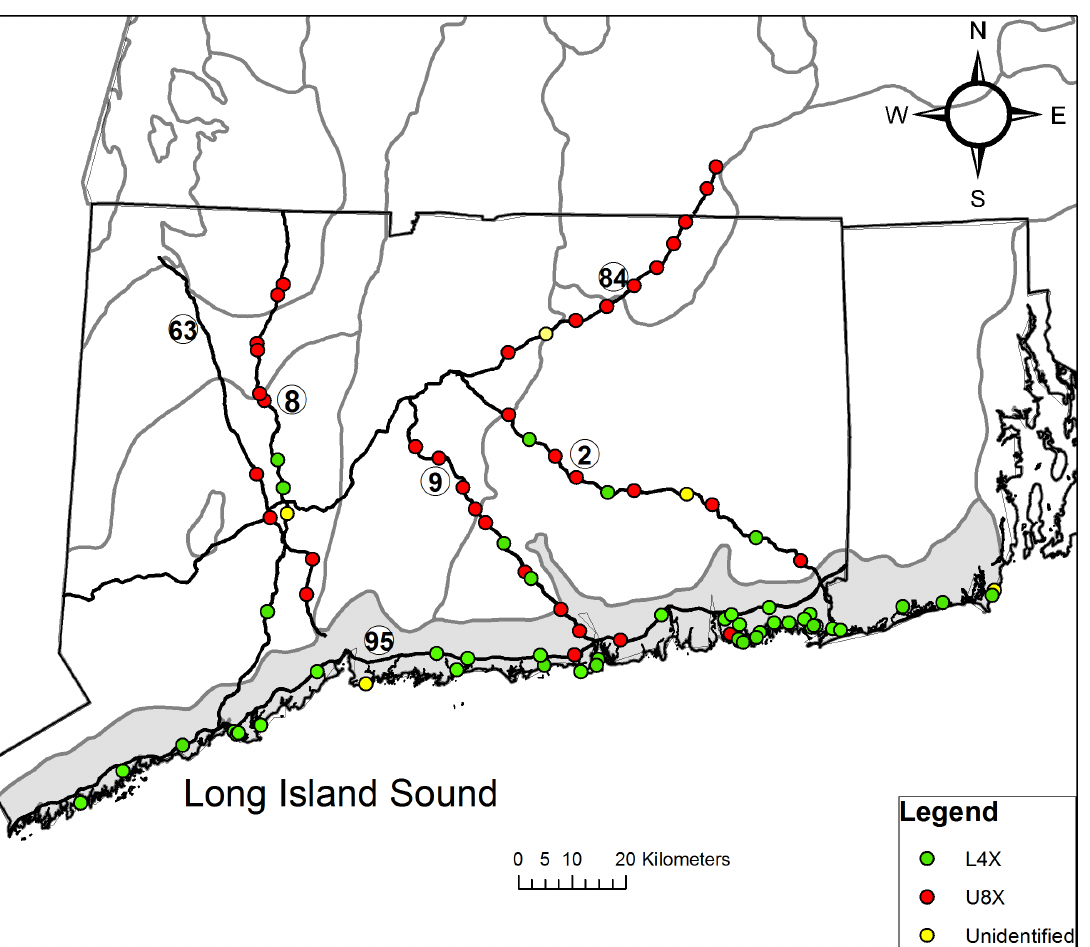
Fig 7. Map of study site showing distribution of switchgrass genotypes. Black lines represent borders of Connecticut and Rhode Island and six roads identified as Routes 63, 8, 9, 95, 84, and 2. Grey lines represent the borders of Level IV sub-ecoregions. The shaded area represents sub-ecoregion 59g Long Island Sound Coastal Lowland (LISCL). Green dots represent plants identified as SNELT or other L4x genotypes; red dots represent plants with an U8x genotype; yellow dots represent individuals that could not be assigned to a specific group.